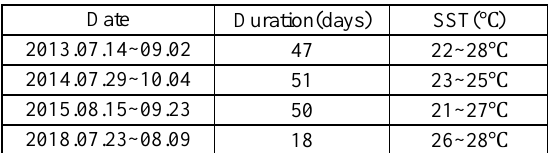
Table 1. Red tide occurrence and duration. SST extracted from the nearest red tide occurrence.